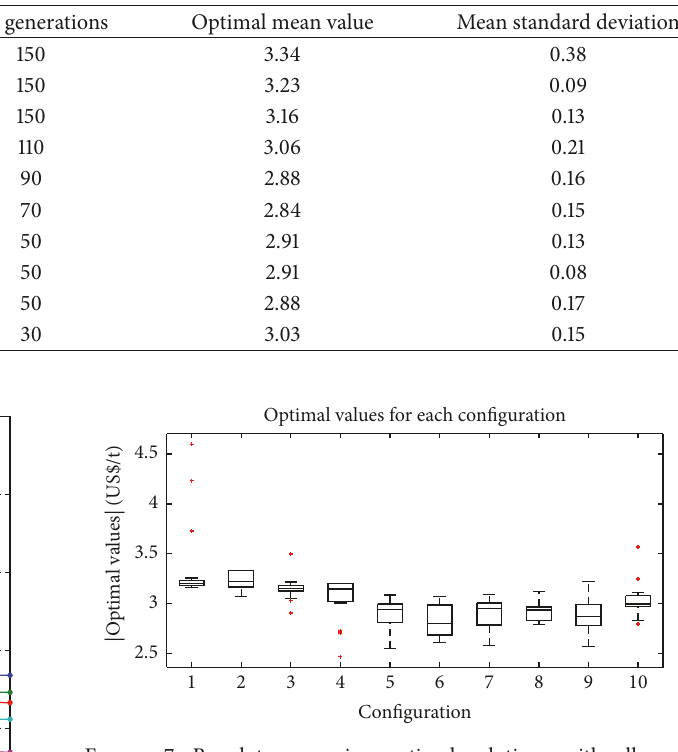
Figure 7: Boxplot comparing optimal solutions with allowed configurations from